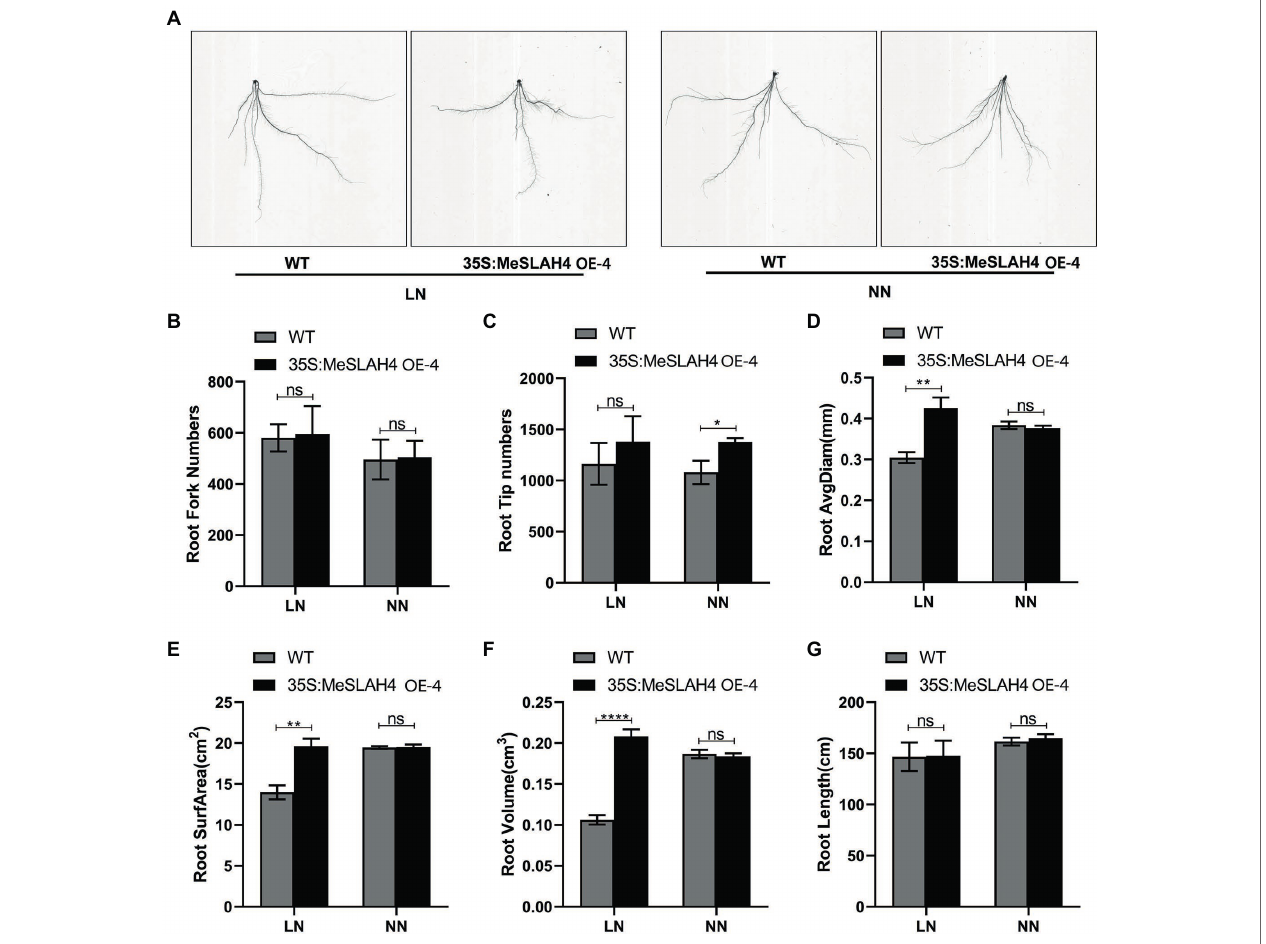
FIGURE 6 | Root phenotypes of the wild type and OE line under different nitrate conditions. (A) Phenotypes of wild type (WT), and MeSLAH4-OE line (35S:MeSLAH4) grown in hydroponic medium treated with LN (0.01 mm NO 3 (C) Root tip numbers. (D) Root average diagram (mm). (E) Root surface area (cm 2 ). (F) Root volume (cm 3 ). (G) Root length (cm) of seedings. The letters “ns” indicate non-significant differences while *, **, ***, and **** represent significant differences at p < 0.05, p < 0.01, p < 0.001, p < 0.0001, respectively on one-way ANOVA